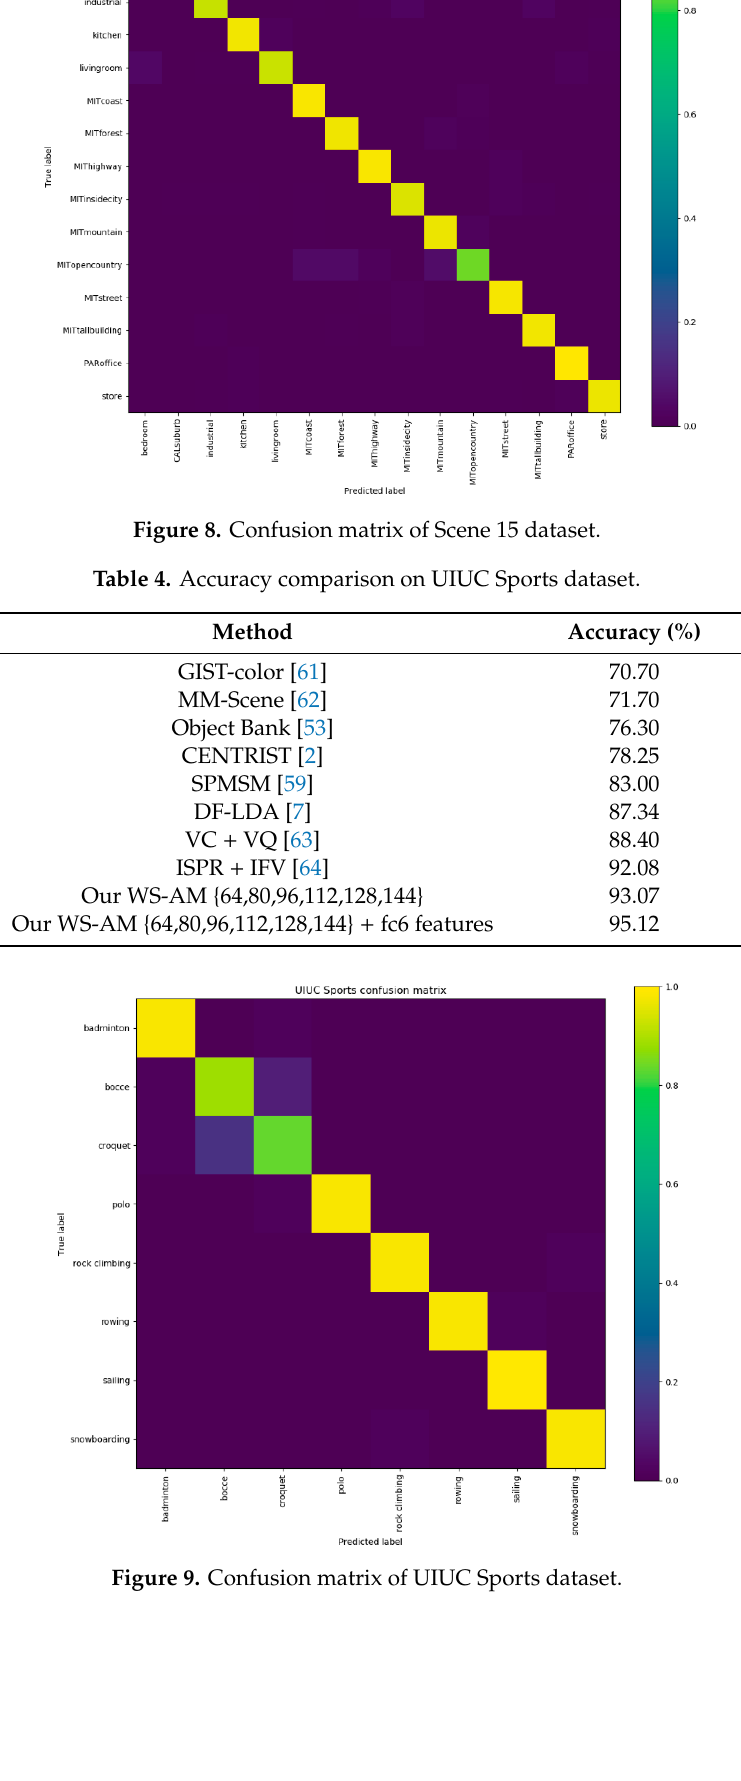
13 of 21 Table 3. Accuracy comparison on Scene 15 dataset. Method